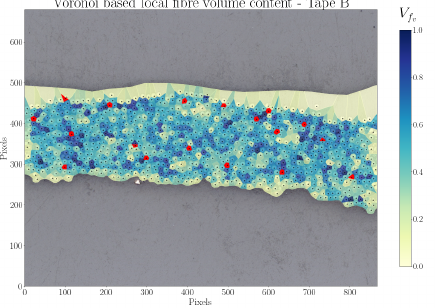
Figure 11. Two adjacent Voronoi analyses of tape